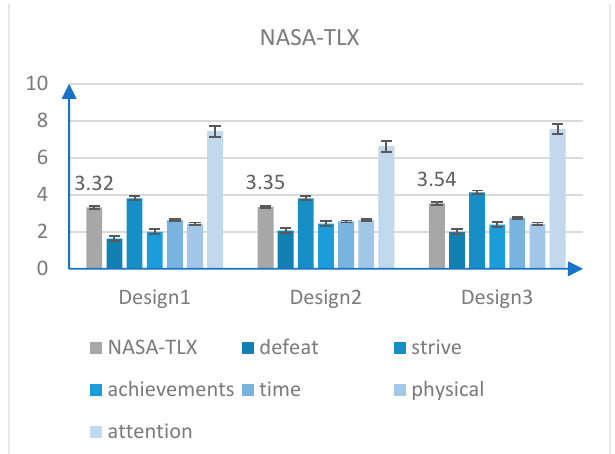
Figure 8. Scores from the ASQ questionnaire. The first column of each design is the ASQ score, and the next three columns are its three-dimensional scores.